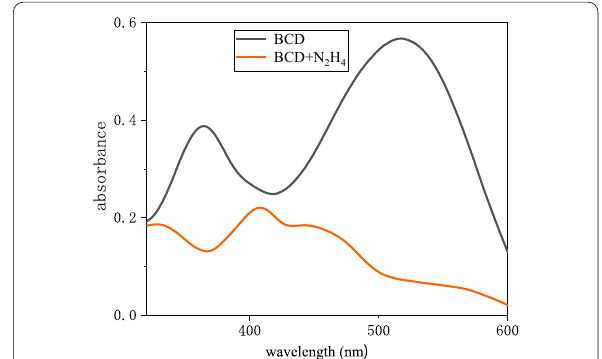
Fig. 1 UV–Vis absorbance spectra of probe BCD (60 μM) in the absence and presence of N 2 H 4 (10 mM) in the DMF-Hepes buffer (7/3, v/v, pH =